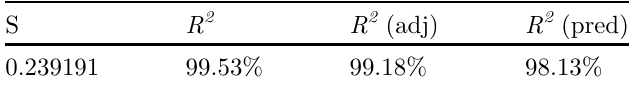
Table 6. Model summary.